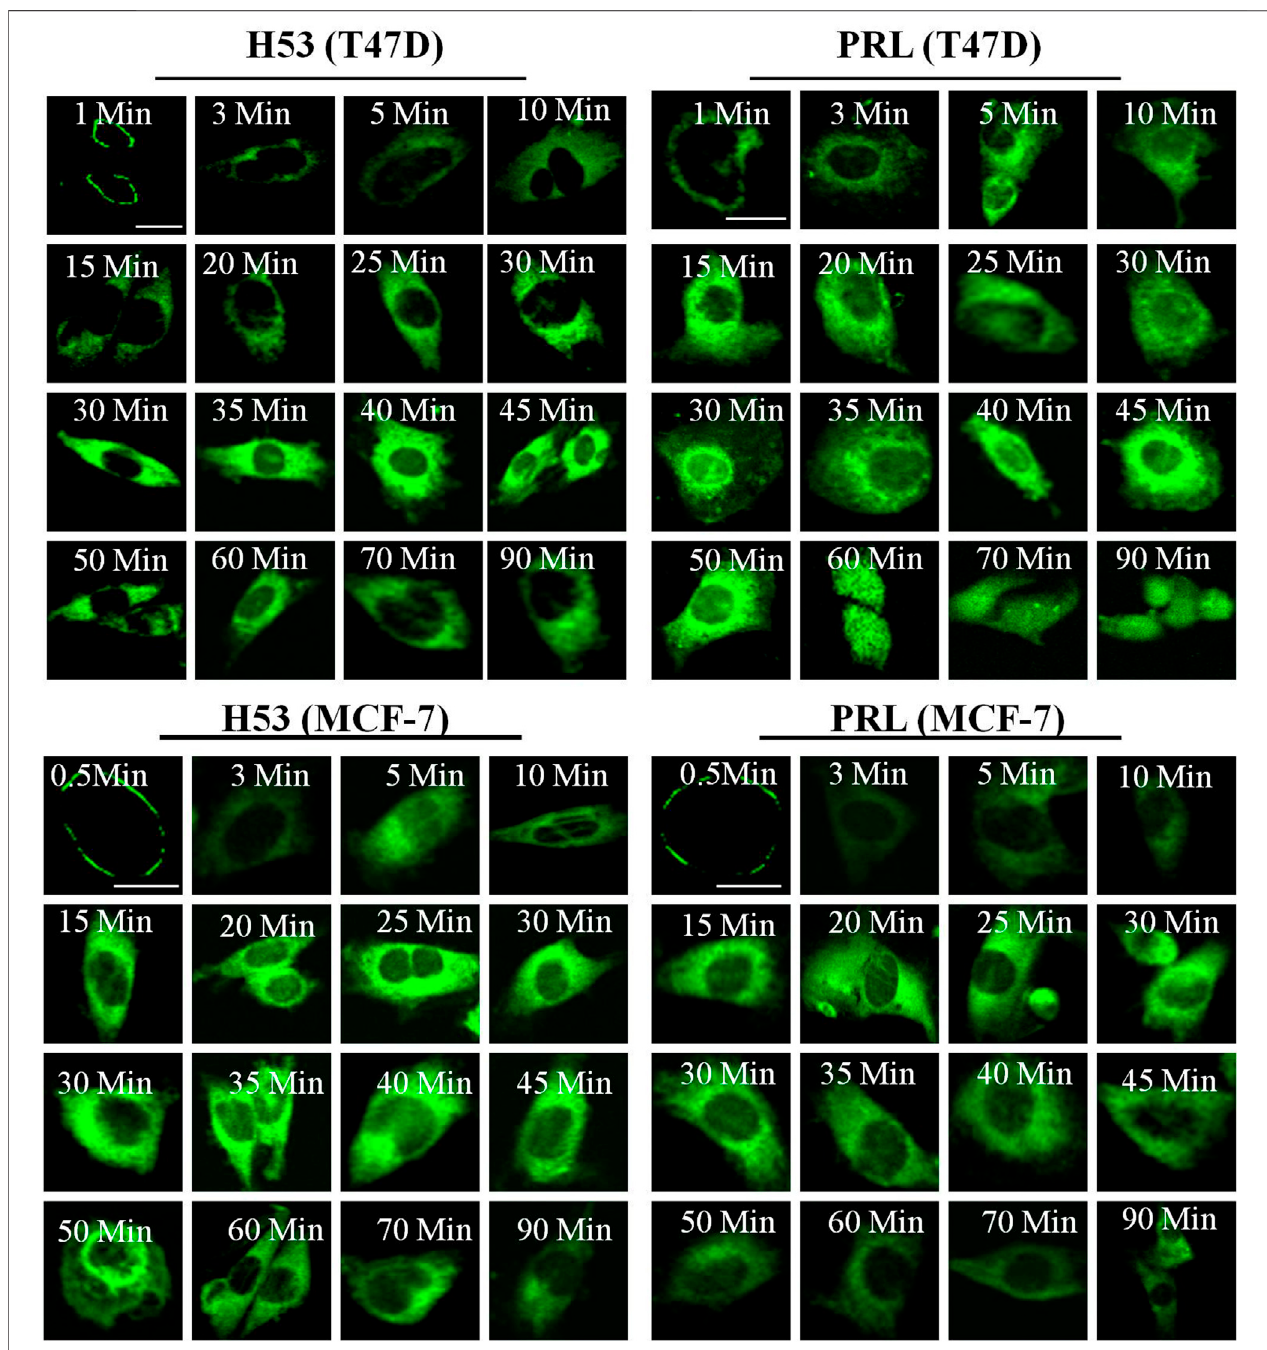
FIGURE5| Internalizationandtraf fi cking ofH53.Thecellswereserum-starvedfor6 h,and thenthecellswereincubated with fl uorescent labeled-PRL,GHorH53 for different time points. After washing, the cell samples were detected by using a confocal laser scanning microscopy (Olympus FV3000).